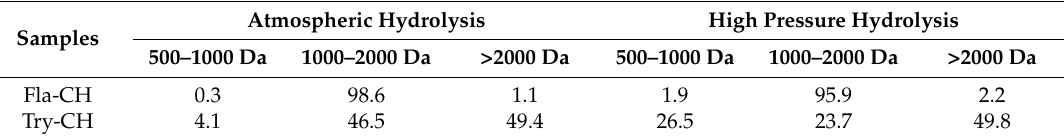
Table 2. Relative area (%) of the peptide peaks obtained in matrix-assisted laser desorption/ionization time-of-flight (MALDI–TOF) mass spectra of casein hydrolysates produced under an atmospheric and high pressure